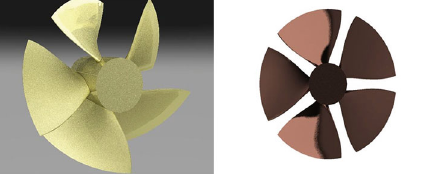
Figure 6: Schematics of the rotor blade produced in PropCad. Table 5: General information of the rotor blade. Number of blades: 5 Diameter 185 Pitch 1.2 Rake 0 Skew angle 3.1